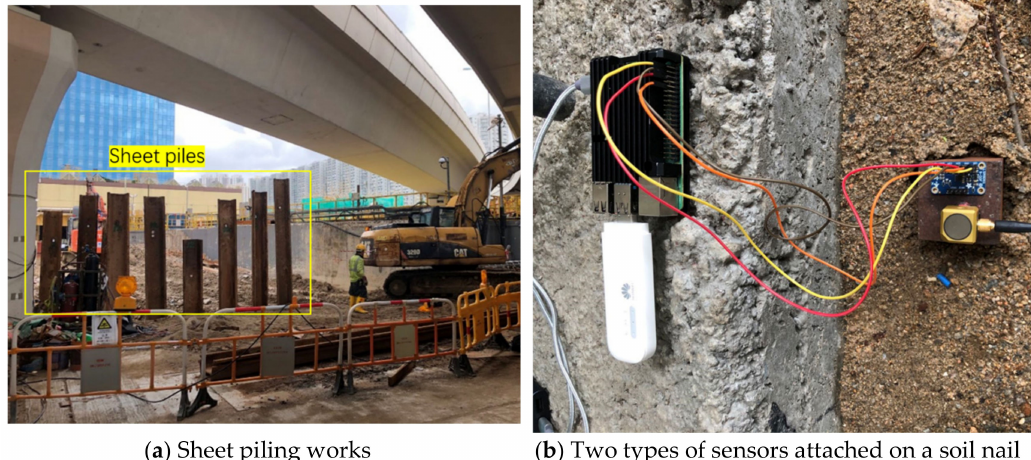
Figure 15. Field tests of the IoT sensing system on a selected construction site in Hong